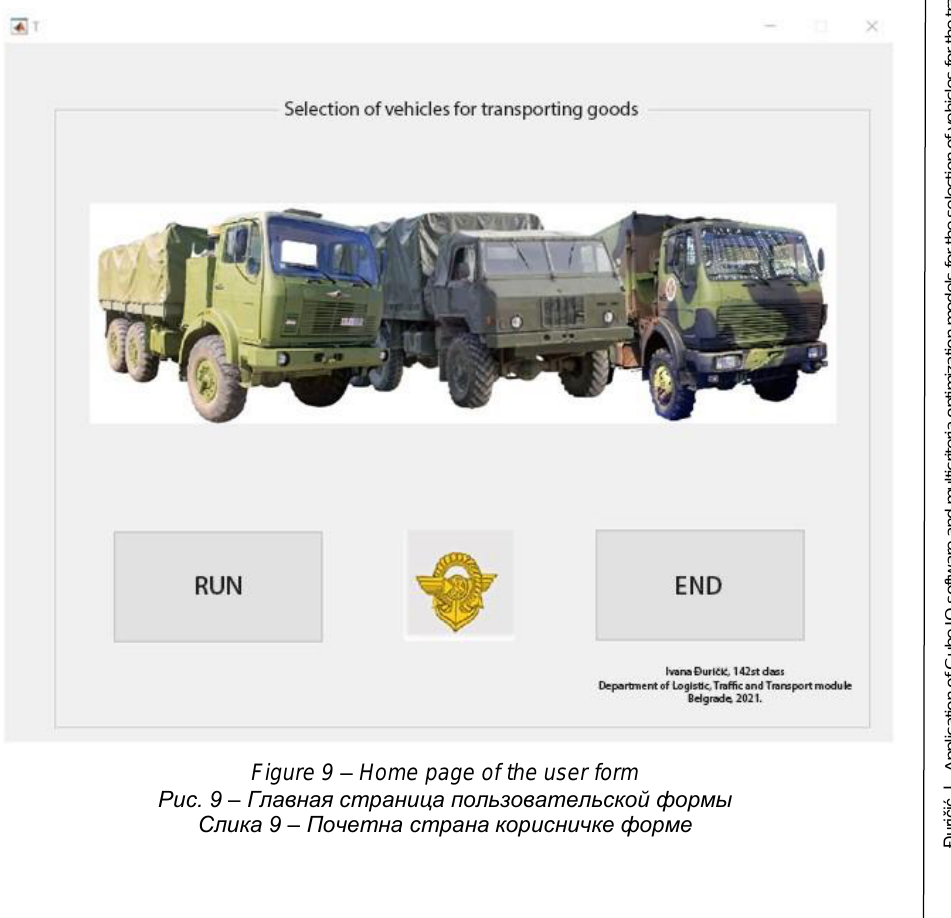
Figure 9 – Home page of the user form Рис. 9 – Главная страница пользовательской формы Слика 9 – Почетна страна корисничке